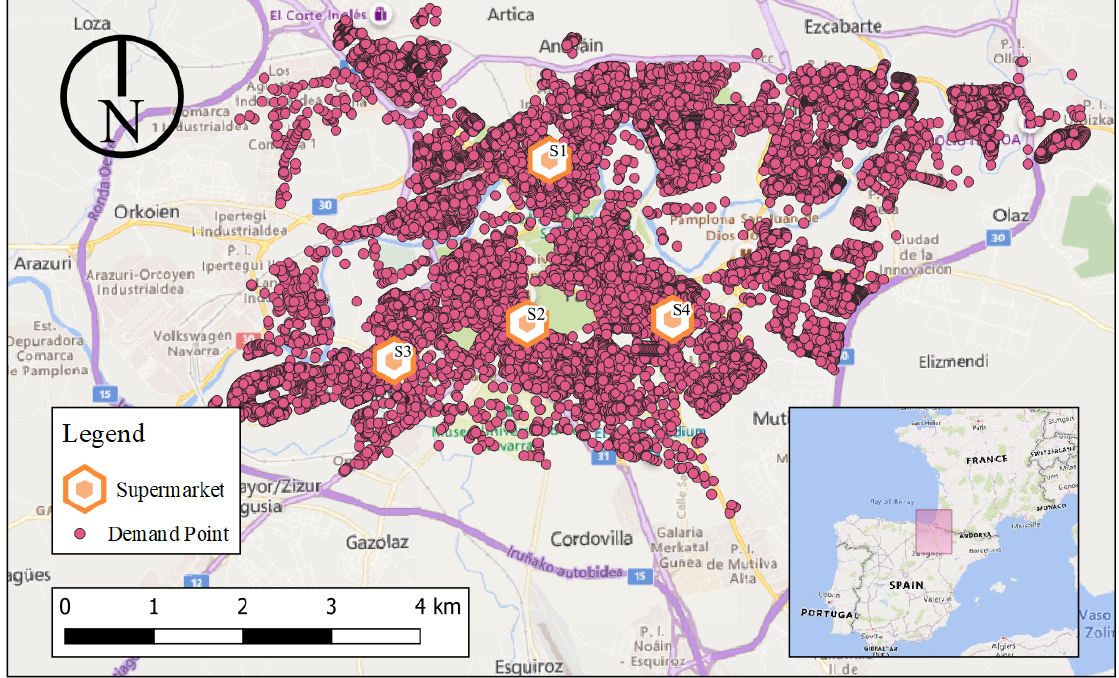
Figure 1. Survey geographical scope, customer and supermarket agents, and Pamplona location in